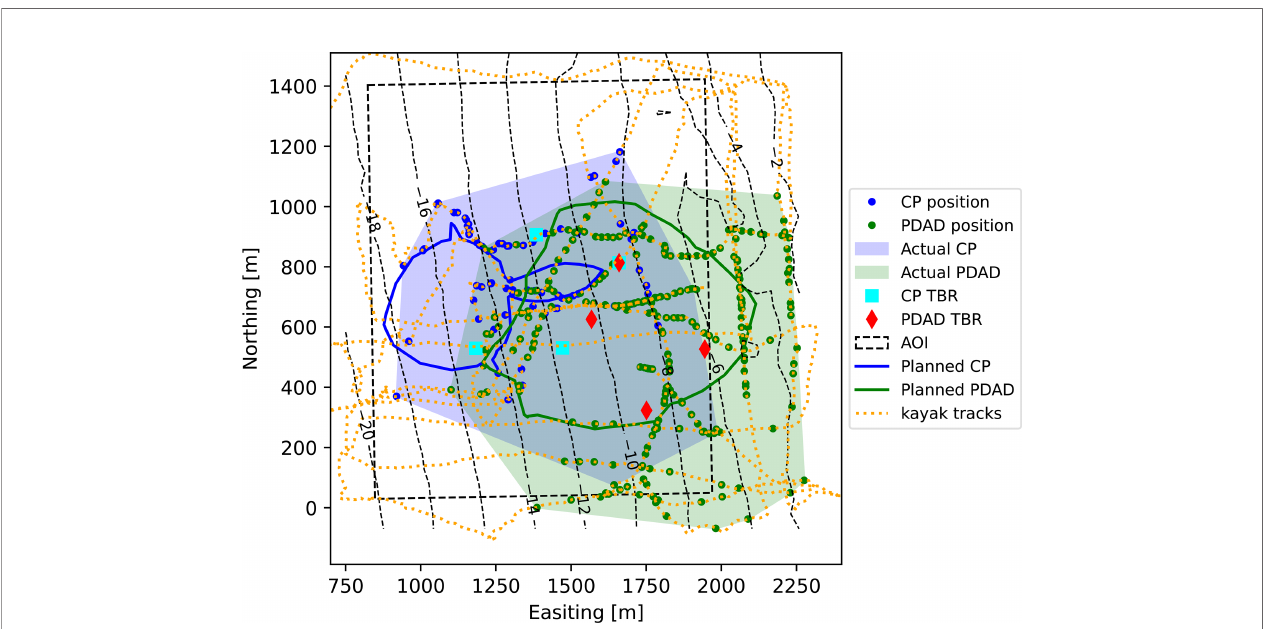
FIGURE 8 | Positioning of tags and coverage areas for CP and PDAD methods. Light blue and green- fi lled areas are the minimum convex hull encompassing all points of CP and PDAD, respectively. Solid lines are the planned usable areas. Triangles are the receivers ’ positions. Blue and green dots are emissions received by at least three receivers of the CP and PDAD sets, respectively.